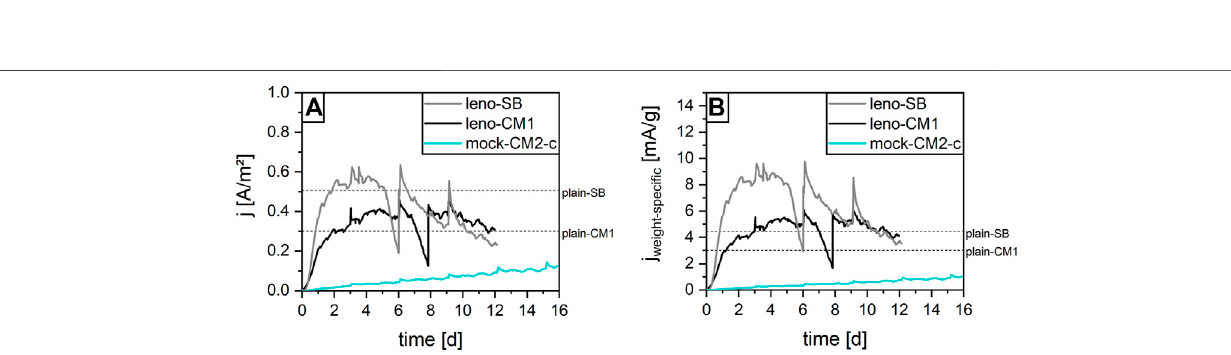
FIGURE5| Performanceoflenofabricsandmocklenofabricsinplatereactorswith S.oneidensis (fed-batch).Currentisnormalizedto2Dprojectedelectrodearea (both sides of the fabric) (A) and electrode weight (B) . Sharp current drops and increases are results from electron donor depletion and new addition. All sample names includethe fi ber type (CM orSB). Dottedlines represent thej max referenceperformanceofplainweavefabrics made from equivalent fi bers asthetwolenofabrics.Leno- CM1 and leno-SB were single experiments; mock-CM2-c is a representative graph from n =